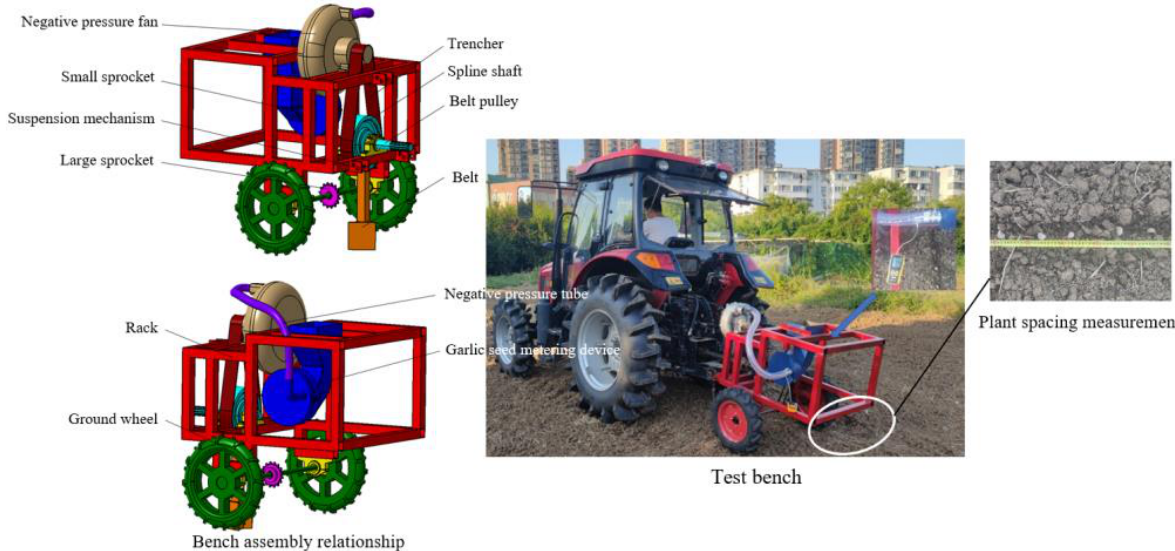
Figure 17. Field trial site.